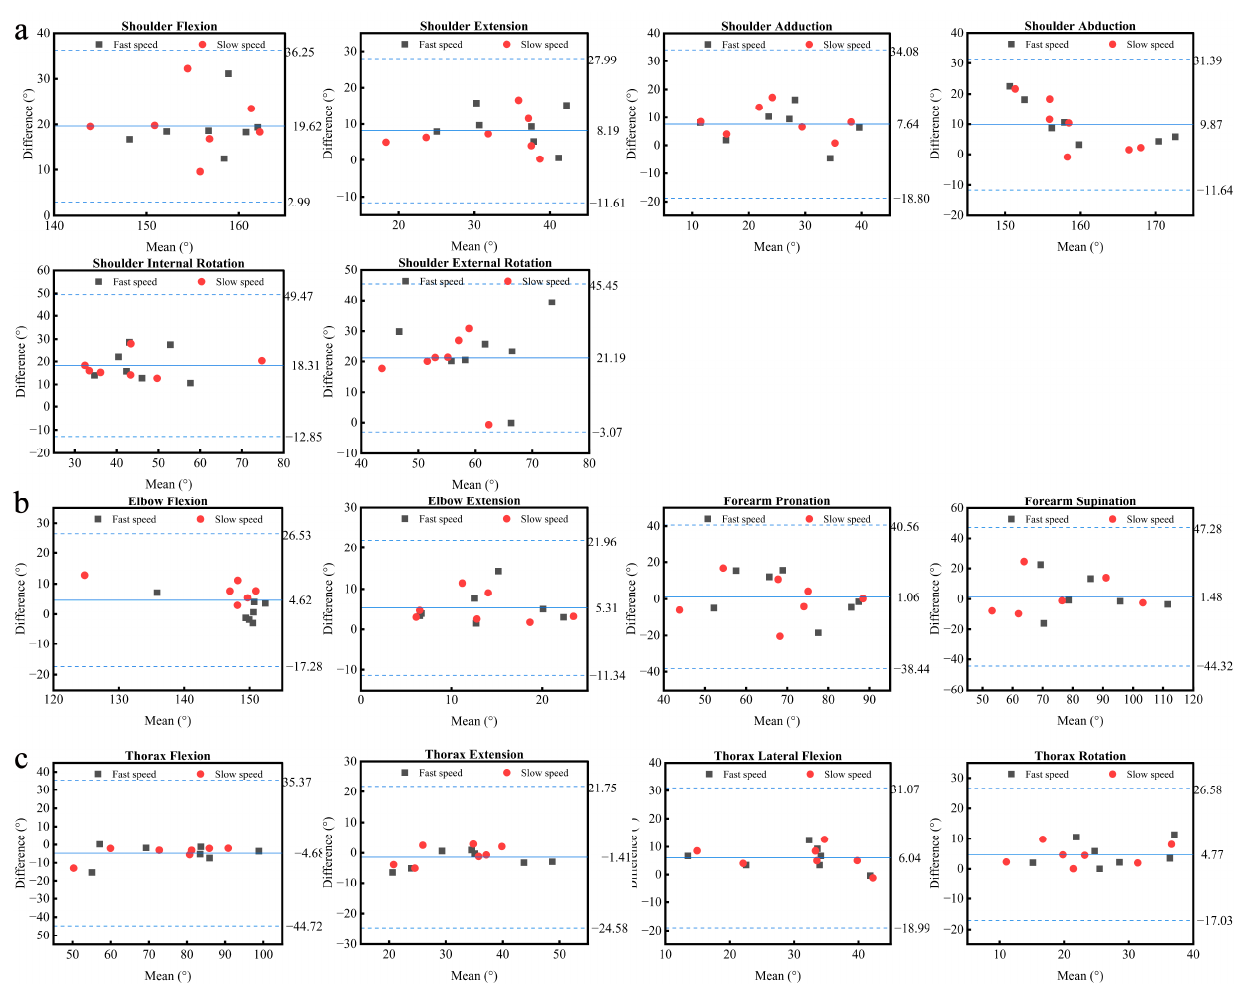
Figure A2. Bland–Altman plots for each absolute angular of the shoulder ( a ), elbow ( b ), and trunk ( c ) in simple tasks. The solid blue horizontal line stands for the mean bias, while the dashed blue horizontal lines indicate the upper and lower 95% confidence intervals. Table A1. Typical error of measurement, SWC0.2; 06; and 1.2 and MDC95% of intertest session.